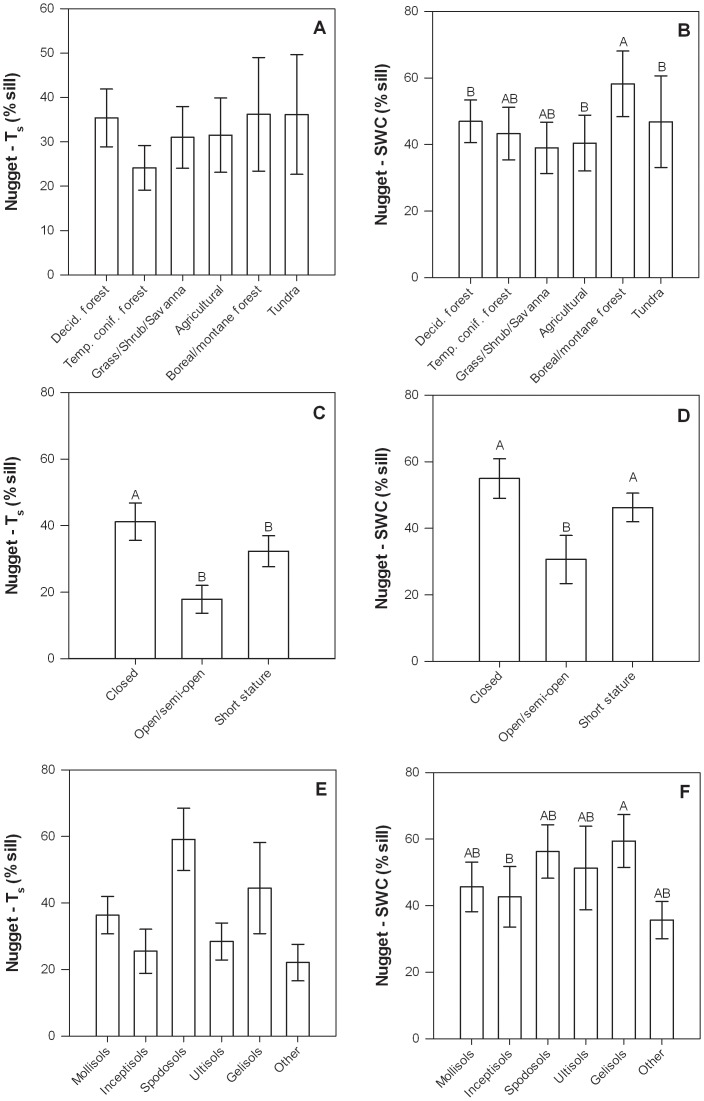
Semivariogram nugget expressed as a percent of the sill for Ts (left column) and SWC (right column) at each site in relation to ecosystem type (a, b), canopy structure (c, d), and soil type (e, f).Error bars represent ±1 SE. Bars with different letter were significantly different (p<0.05) based on Tukey HSD tests. The letter “A” corresponds to the largest least square mean(s) and subsequent letters (B, C, …) correspond to progressively smaller least square means.